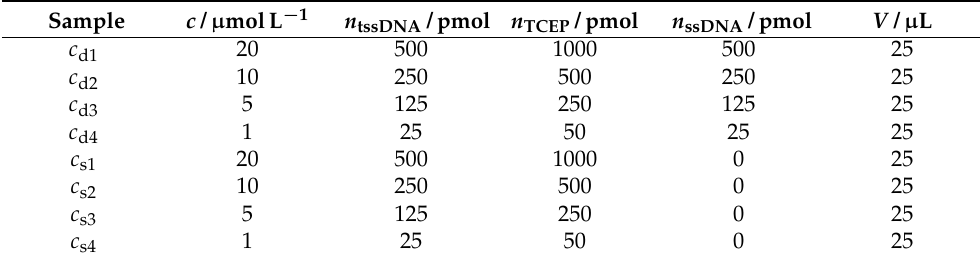
Table A1. Composition of DNA samples including sample concentration c , amount of substance n and volume V